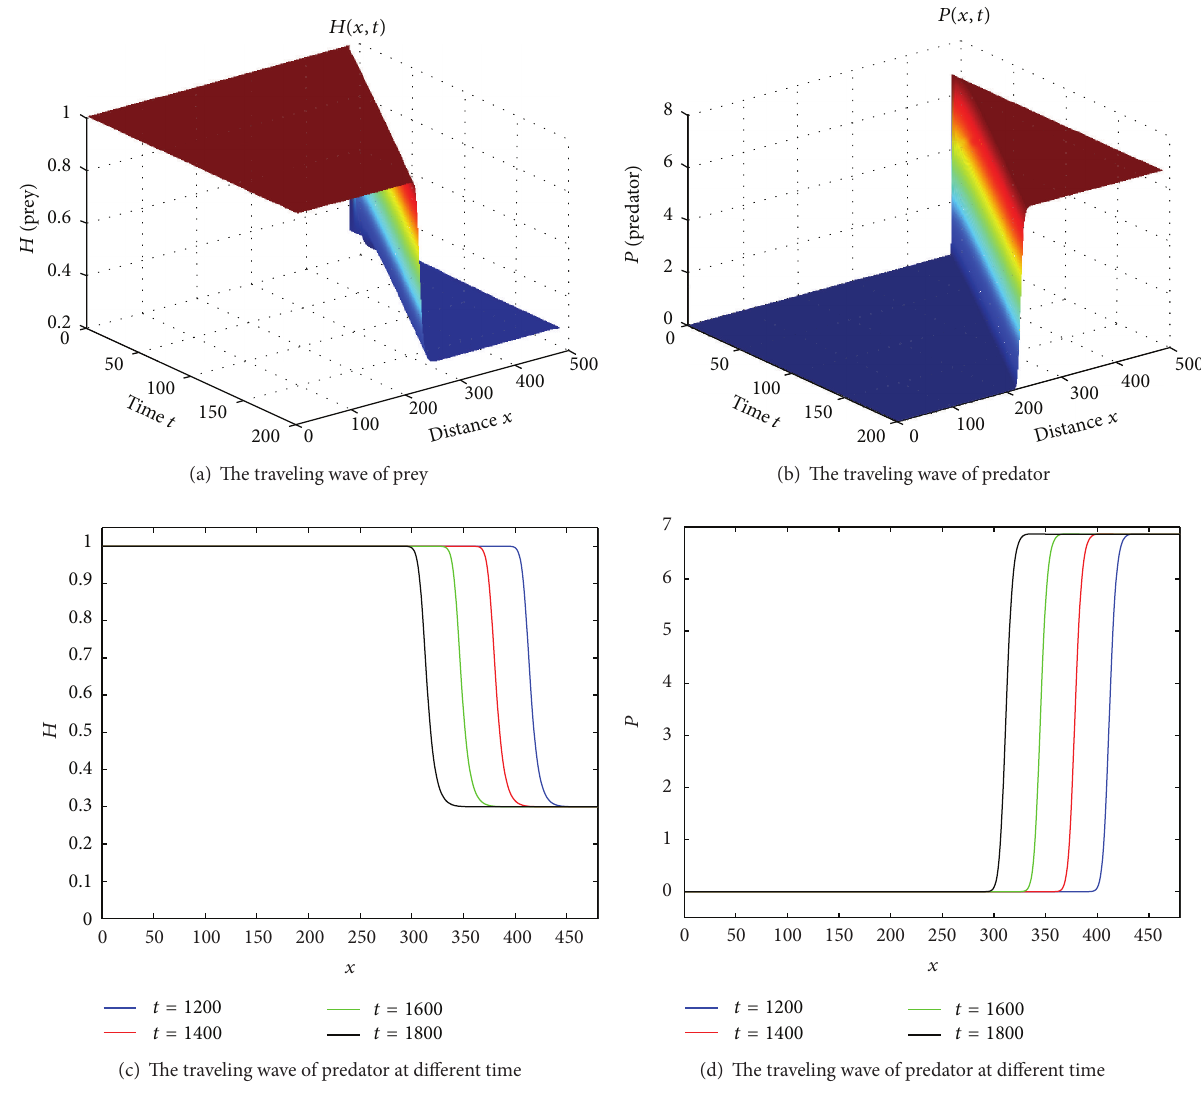
Figure 1: The traveling wave solution of system (8) from 𝐸 1 (1 , 0) tends to 𝐸(𝐻 ∗ ,𝑃 ∗ ) monotonously with the parameters 𝐷 = 0.8 , 𝑟 = 1 , 𝑎 = 1 , 𝑚 = 0.3 , 𝑏 = 6.65 , 𝑑 = 0.5 , and 𝛽 = 0.5